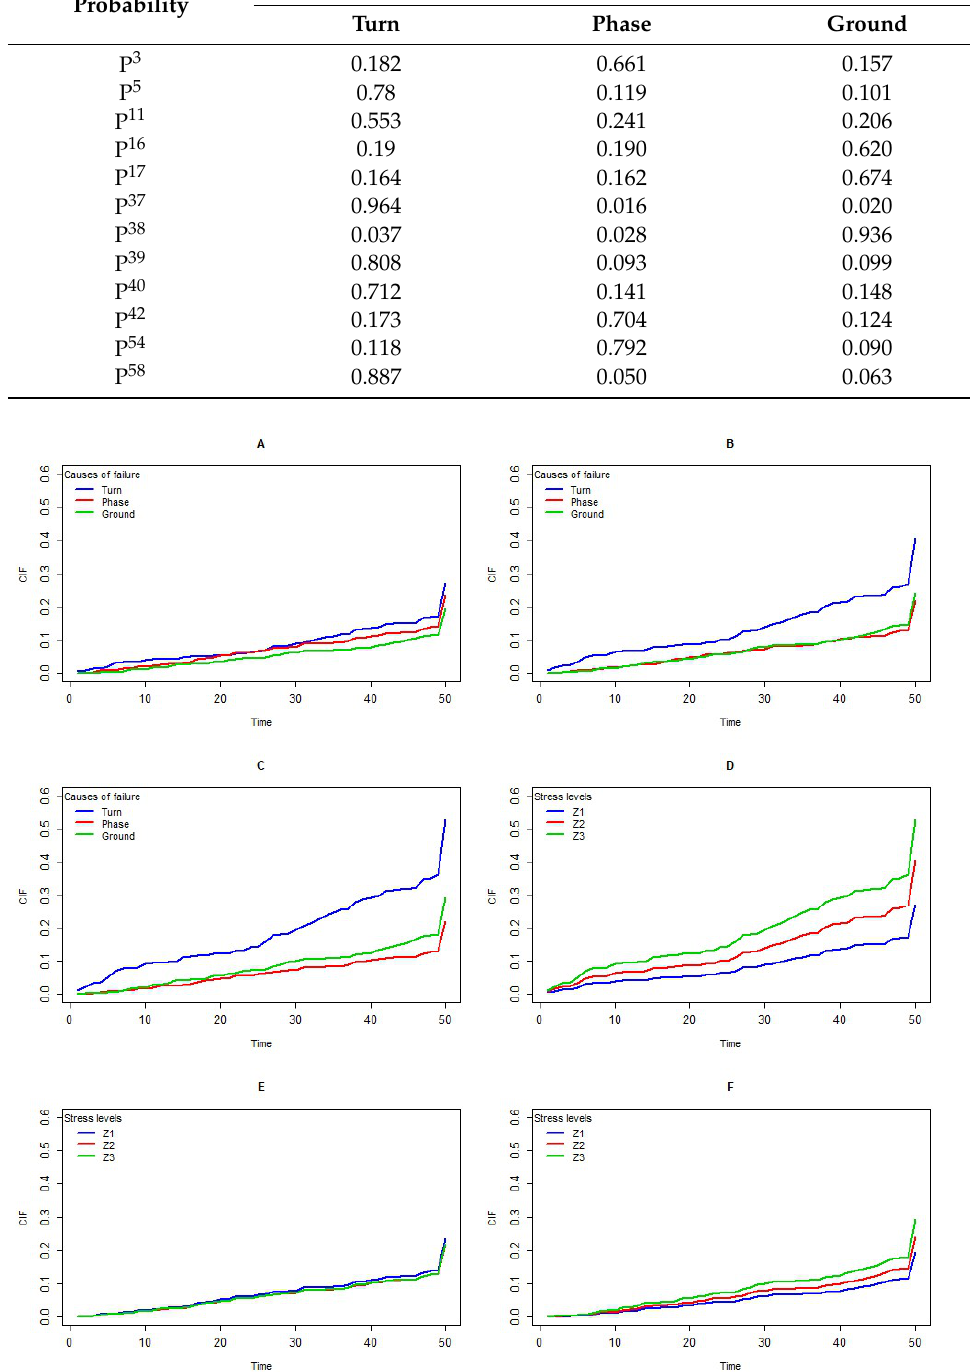
Figure 3. Comparisons of cumulative incidence functions (CIF) from: ( A ) three causes for stress level 1, ( B ) three causes for stress level 2, ( C ) three causes for stress level 3, ( D ) three levels of stress for cause turn, ( E ) three levels of stress for cause phase, and ( F ) three levels of stress for cause